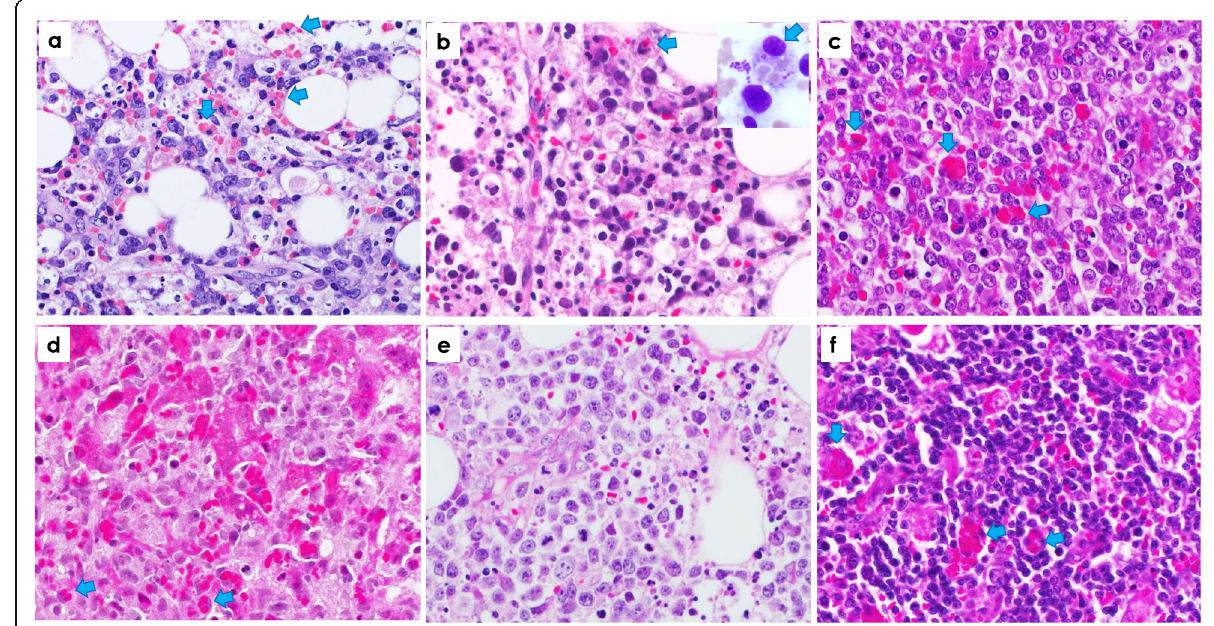
Fig. 1 a Diffuse infiltrate of large atypical lymphocytes and a few erythrophagocytes (arrow) in bone marrow (patient No. 4). b Bone marrow invasion by atypical medium-sized and some large atypical lymphocytes with hyperchromatic nuclei in patient No. 12. Histiocytic reaction and a few erythrophagocytes were detected. An erythrophagocyte and atypical lymphocyte in a smear. c Lymph node involvement of large atypical lymphocytes and some erythrophagocytes in patient No. 5. d Diffuse infiltrates of large atypical lymphocytes in the hepatic lobules (patient No. 11). Destructed hepatic trabeculae are observable in the right upper part, and a few erythrophagocytes are seen. e Diffuse infiltrate of large atypical lymphocytes and many apoptotic bodies in involved subcutaneous tissue of patient No. 13. f Diffuse infiltrate of small lymphocytes with mild atypia and several scattered erythrophagocytes in lymph node of patient No. 16. × 400